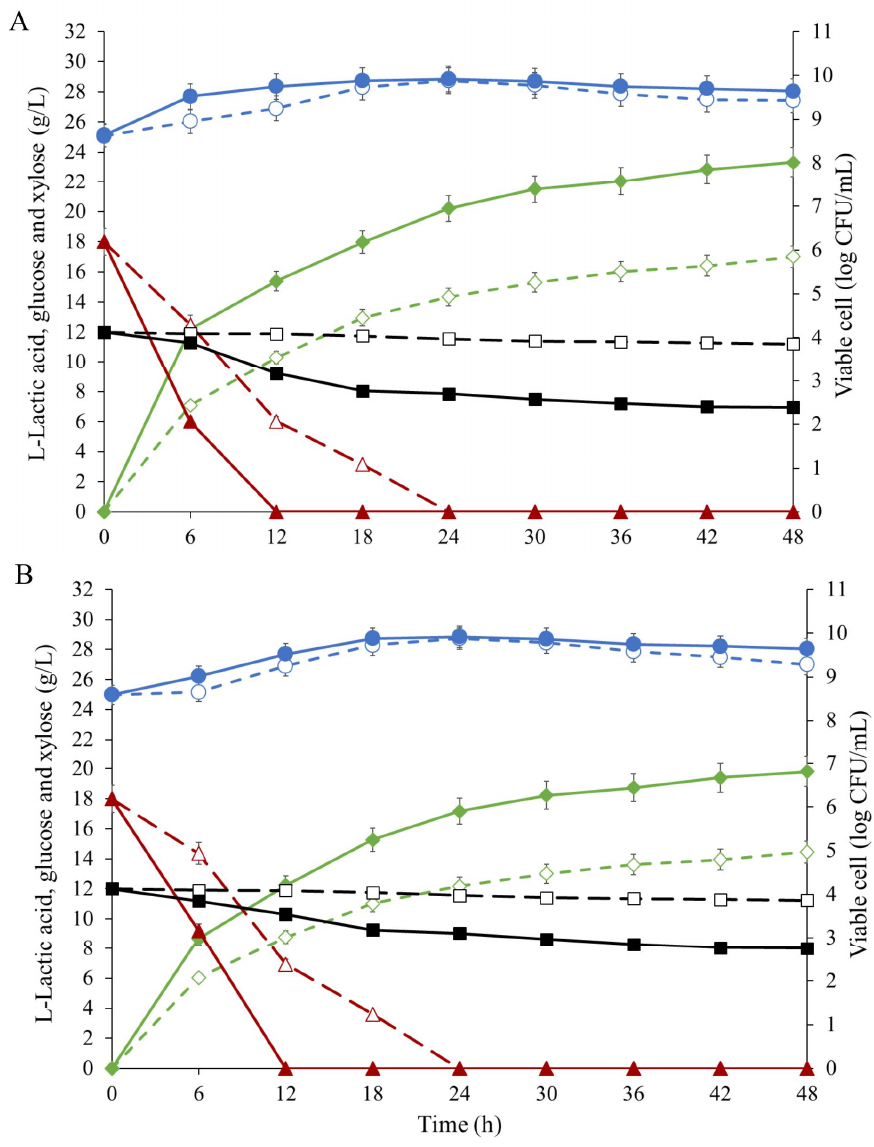
Figure 4. Comparison of lactic acid production by coculture of E. mundtii WX1 and L. rhamnosus SCJ9 (solid line) and single-culture of E. mundtii WX1 (dashed line) in MRS with 30 g/L mixed glucose-xylose carbon source without furfural ( A ) and in the presence of 2 g/L furfural ( B ) at 37 °C for 48 h. Symbols; ( , - - - -) lactic acid, ( ▲ , - - - -) glucose, ( , - - - -) xylose and ( , - - - -) viable cell.